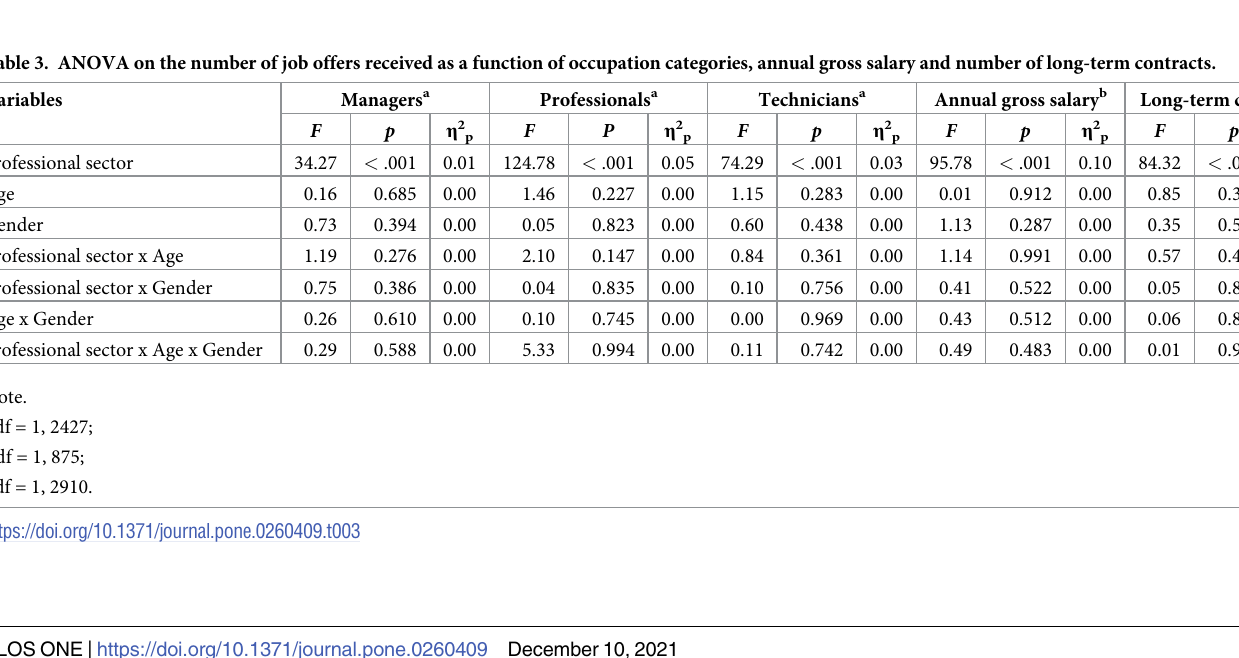
values and therefore were not analyzed. We conducted a 2 (professional sector: female-domi- nated vs. male-dominated) x 2 (age: 24 vs. 38) x 2 (gender: female vs. male) ANOVA on each of the variables of interest. These variables were (a) the number of job offers received as a func- tion of occupation category, (b) the annual gross salary, and (c) the number of long-term con- tracts. Table 3 shows the analyses of variance on these variables. As can be seen in Table 3, with respect to the number of job offers received as a function of occupation categories, the main effects of age and gender were not statistically significant. Nei- ther were any of the interactions with age and gender, indicating that the manipulations of age and gender had no impact on the number of job offers received as a function of occupation category. However, we found a significant main effect of the professional sector. In the male- dominated sector, as compared to the female-dominated sector, candidates received signifi- cantly more offers for managers, t (2427) = 5.85, p < .001, d = 0.24; and technicians, t (2427) = 8.62, p < .001, d = 0.35; and less offers for professionals, t (2427) = -11.20, p < .001, d = -0.45.